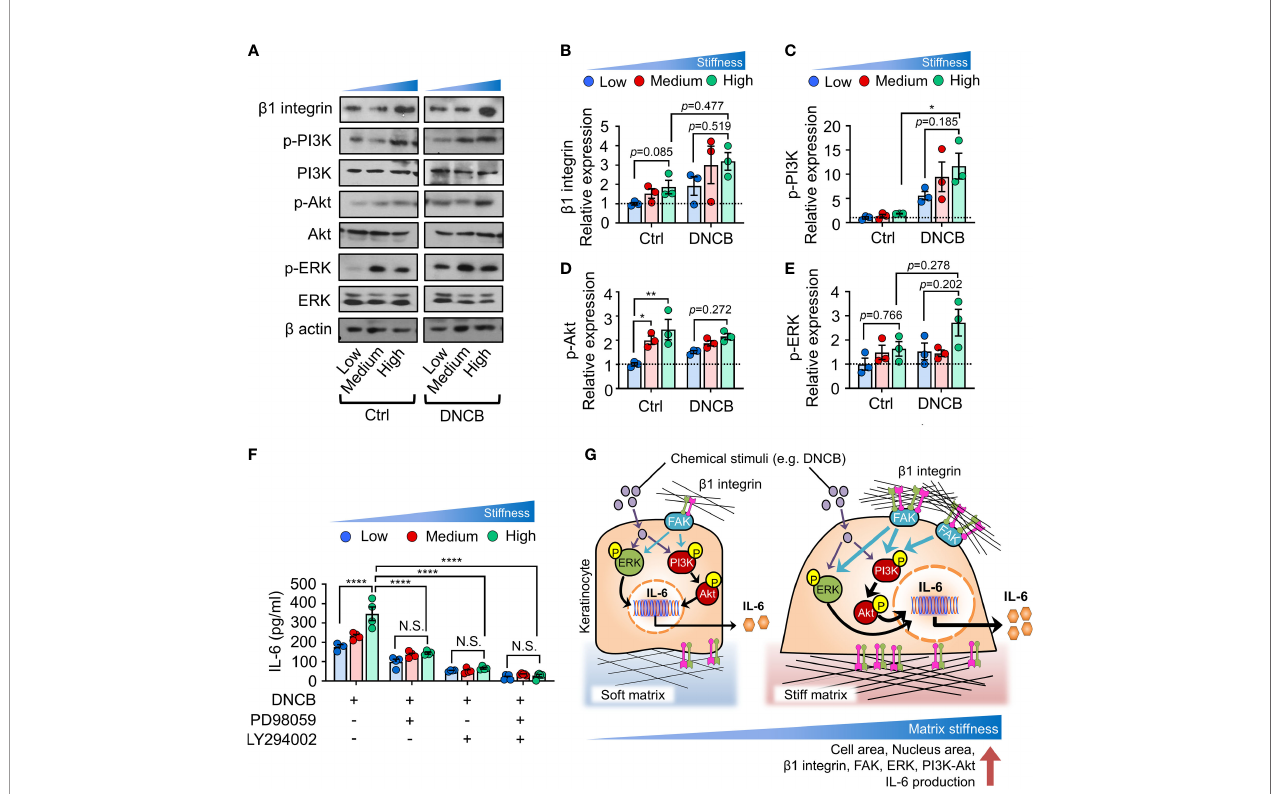
FIGURE 4 | ERK and PI3K/Akt pathways are involved in matrix stiffening-mediated IL-6 production. (A) Immunoblot analysis of b 1 integrin, p-PI3K, PI3K, p-Akt, Akt, p-ERK, ERK, and b actin in HaCaT cells cultured on substrates with low (20 kPa), medium (500 kPa) and high (1200 kPa) stiffness in response to 0.1% DMSO (Ctrl) and DNCB. (B – E) Quanti fi cation of the band intensity ratio for b 1 integrin: b actin (B) , p-PI3K:PI3K (C) , p-Akt : Akt (D) , and p-ERK : ERK (E) . Data are normalized to 0.1% DMSO-treated cells (Ctrl) on substrates with low stiffness (B – E) . (F) ELISA for IL-6 in the culture supernatants from HaCaT cells cultured on substrates with low, medium, and high stiffness in response to DNCB in the absence or presence of PD98059 or/and LY294002. n = 3~4/group. Data represent the mean ± S.E.M. * p < 0.1; ** p < 0.01; **** p < 0.0001 by two-way ANOVA. N.S., nonsigni fi cant. (G) A model describing matrix-stiffness-driven regulation of IL-6 production in response to chemical stimuli in keratinocytes. Keratinocytes sense matrix rigidi fi cation through the activation of b 1 integrin and subsequent FAK, which in turn may lead to phosphorylation of ERK and PI3K/Akt. This mechanotransduction pathway coordinates chemical stimuli such as DNCB to enhance IL-6 production in